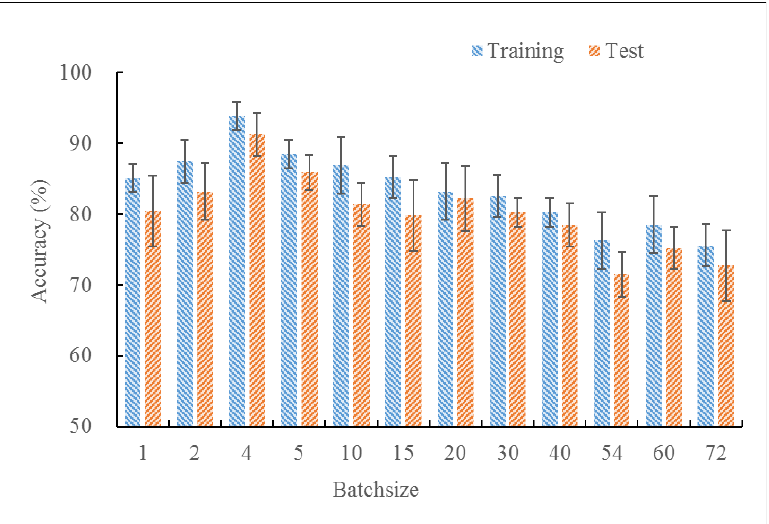
Figure 13. The relationship between learning rate and accuracy rate.